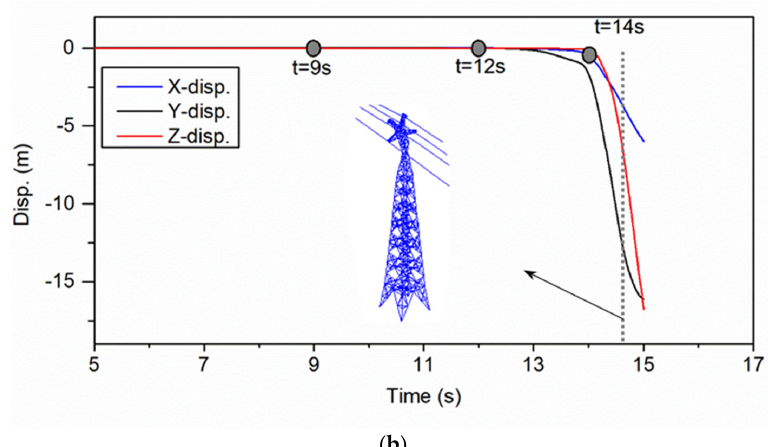
Figure 10. Displacement response at tower tops under Case 1. ( a ) Tower 2; ( b ) Tower 3.